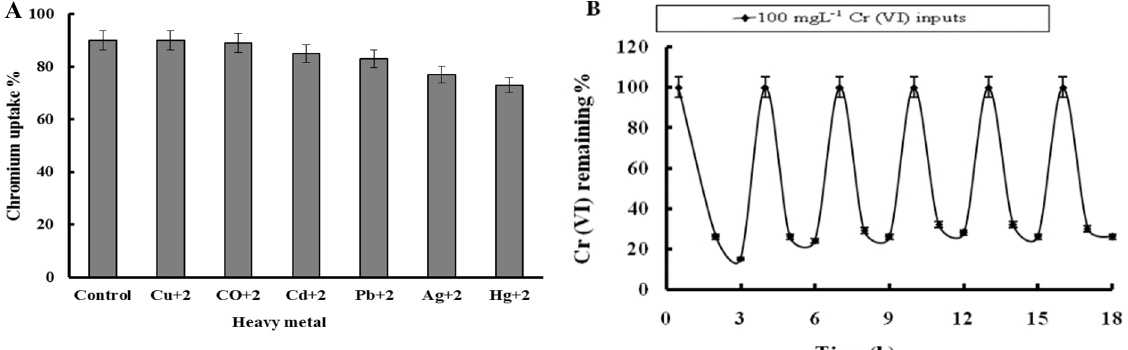
Fig. 2. (A) The effect of heavy metals on Cr(VI) reduction (%) by Alcaligenes sp. CKCr-6A, Error bars represent standard error. (B) Repeated detoxification of 100 mg/L Cr(VI) by CKCr-6A strain at 37°C in LB medium under 180 rpm of